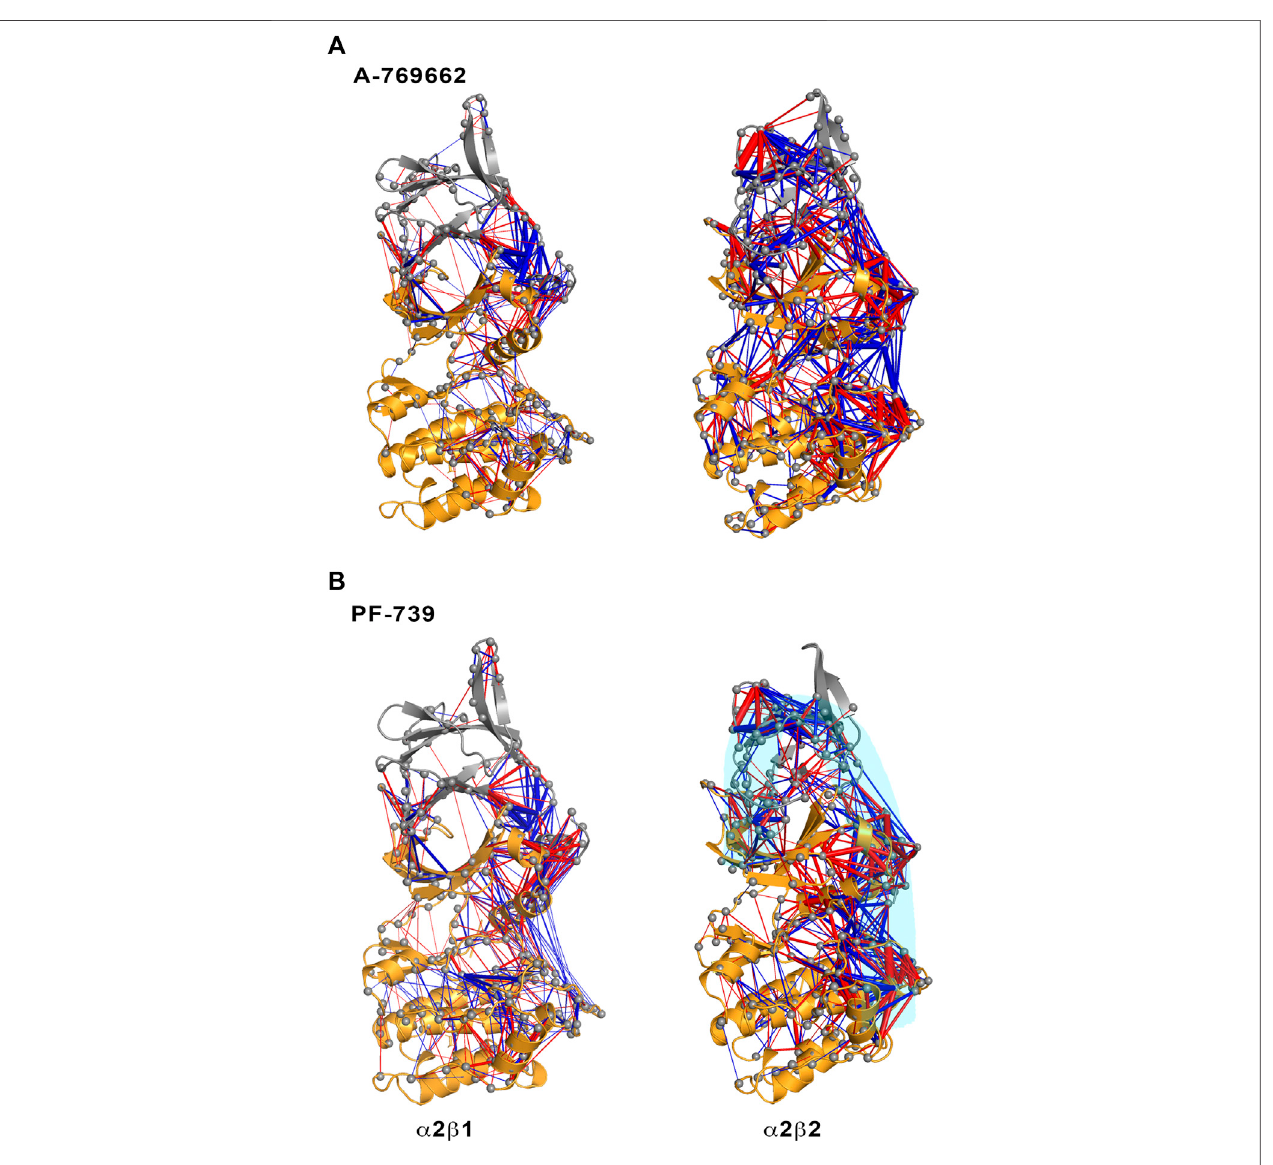
Frontiers in Molecular Biosciences |